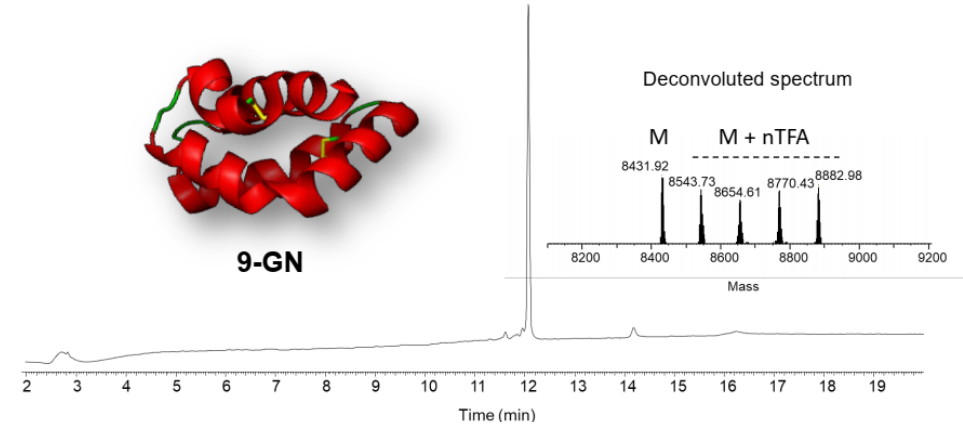
Figure 9. UPLC-MS analysis of synthetic 9-GN . UV detection at 215 nm. M (average mass) calcd. 8431.79, obs. 8431.9. 9-GN is a cationic protein that shows several TFA adducts in its deconvoluted